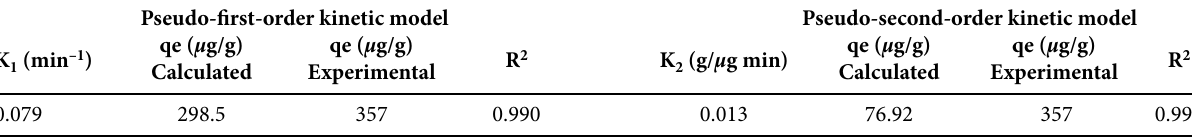
Table 2. Kinetic parameters for the Cr(VI) sorption onto isatin based Amberlite XAD-2 resin Pseudo-first-order kinetic model